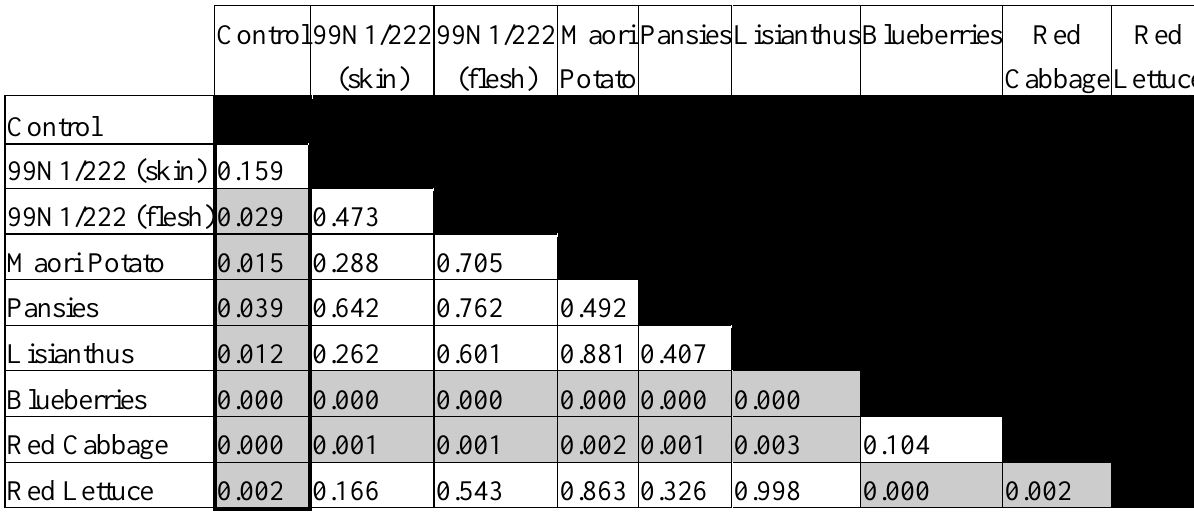
Table 4 . P-values determined from unpaired t-tests for tail extent moment in the 37 ºC H O treatment group. Shaded boxes represent significant differences (p  0.05). 2 2